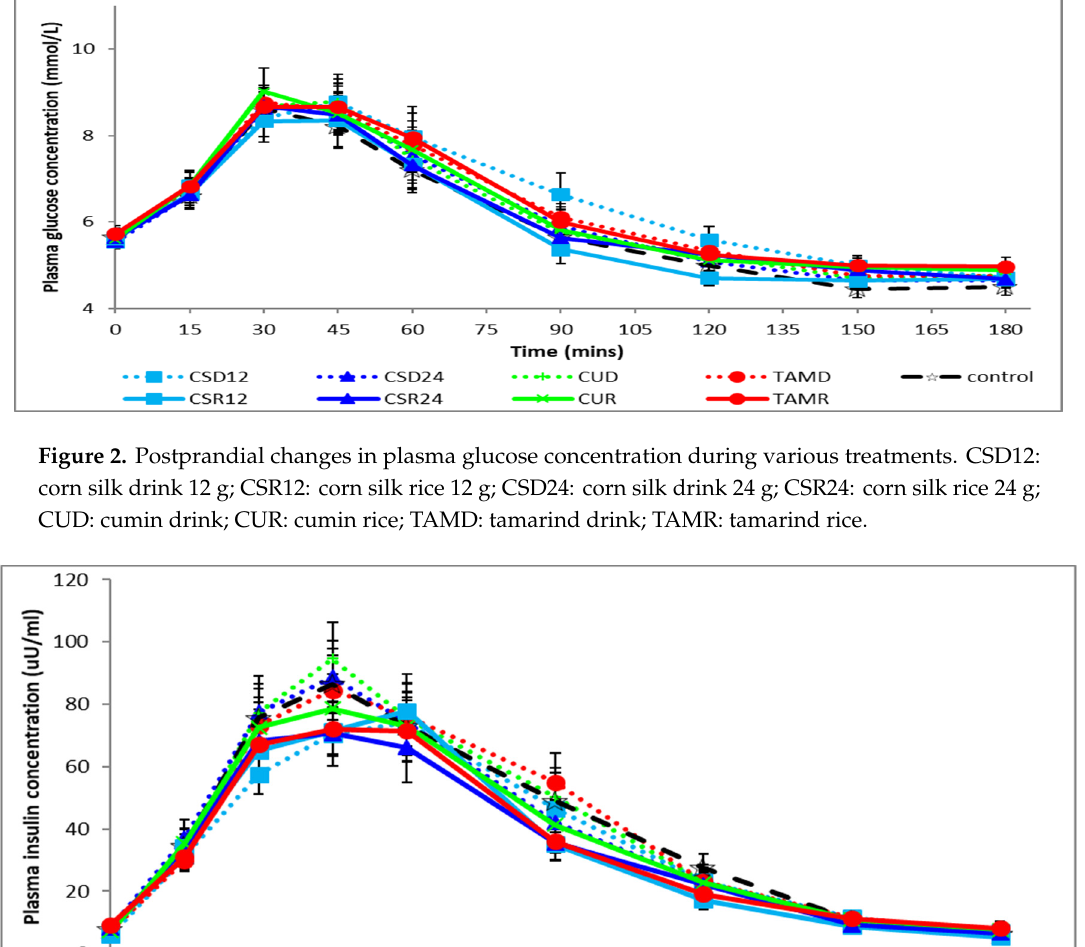
Figure 3. Postprandial changes in plasma insulin concentration during various treatments. CSD12: